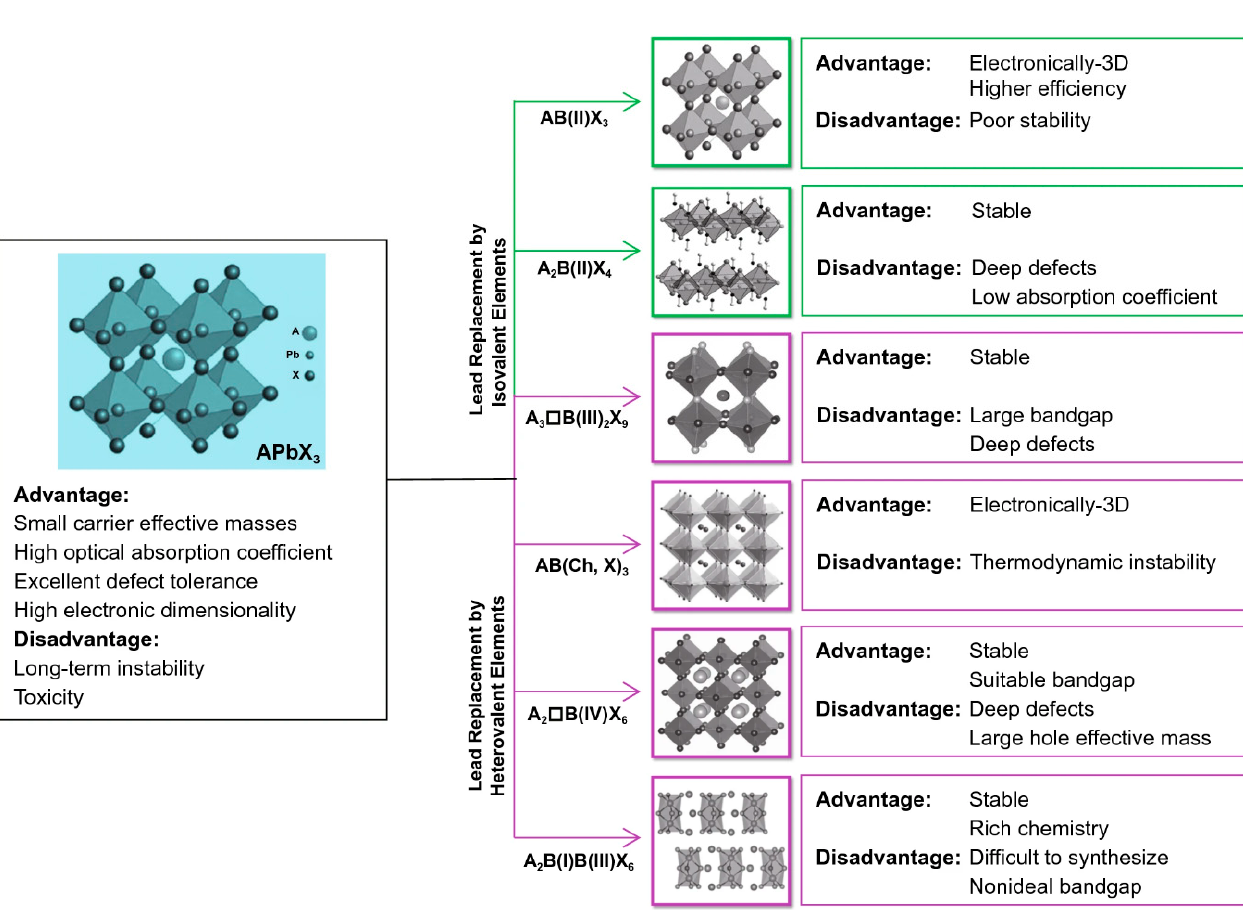
Figure 3. Schematic illustration of the approaches and consequences of potential Pb replacement. bottom). Reprinted/adapted with permission from Ref. [72]. Copyright © 2022 Springer Nature Switzerland AG. Part of Springer Nature.